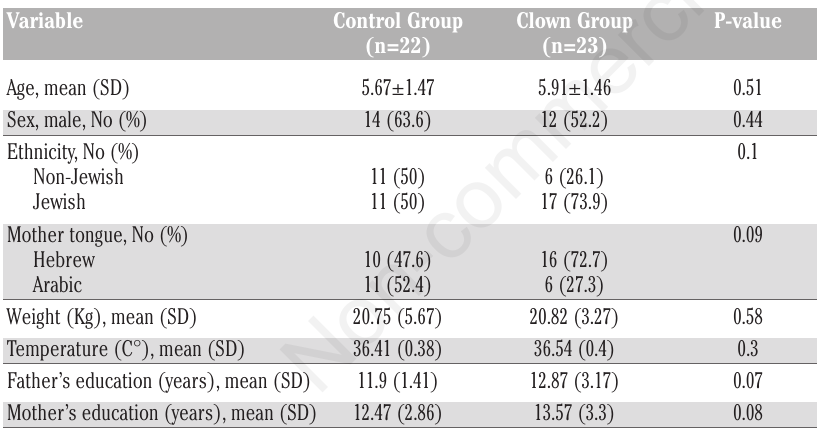
Table 1. Cohort characteristics.